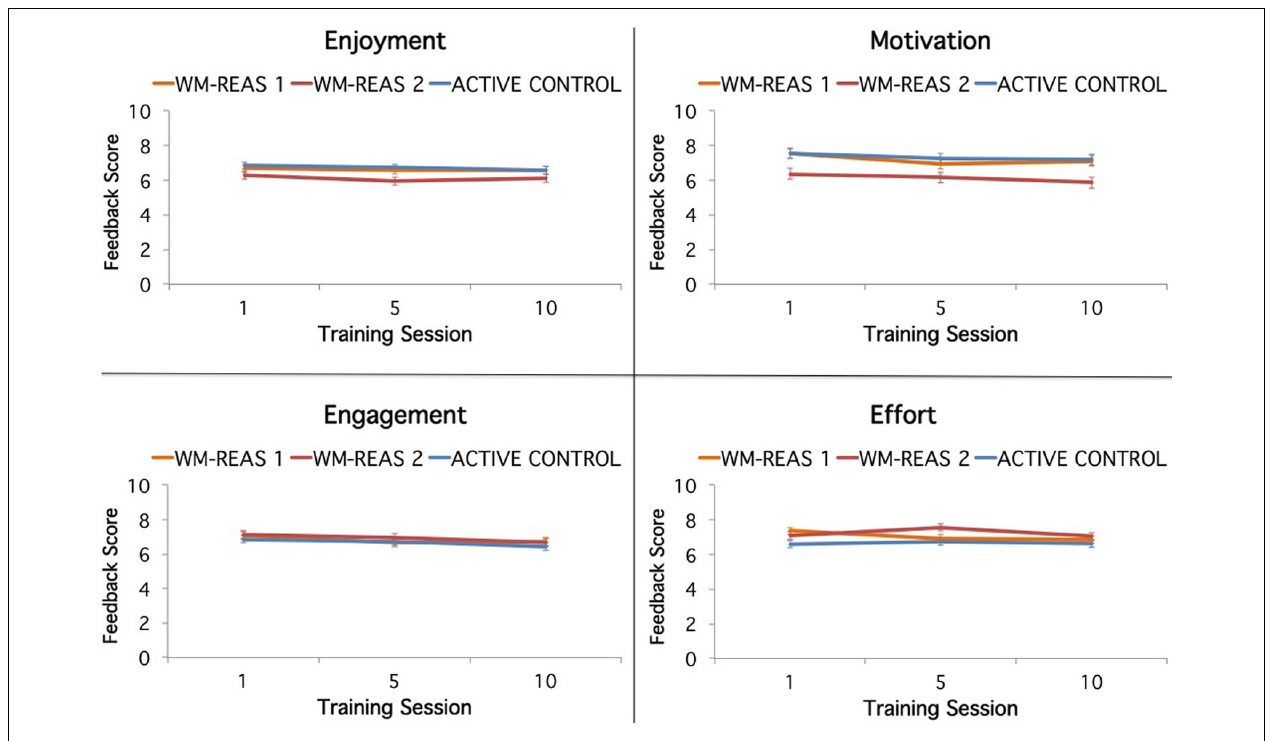
FIGURE 2 |Training game feedback as a function of group and session. Feedback regarding game enjoyment, motivation, engagement, and effort were collected during the first, fifth, and last training sessions. Feedback scale: 1 = least, 5 = neutral, 10 = greatest. Error bars represent ± SEM.